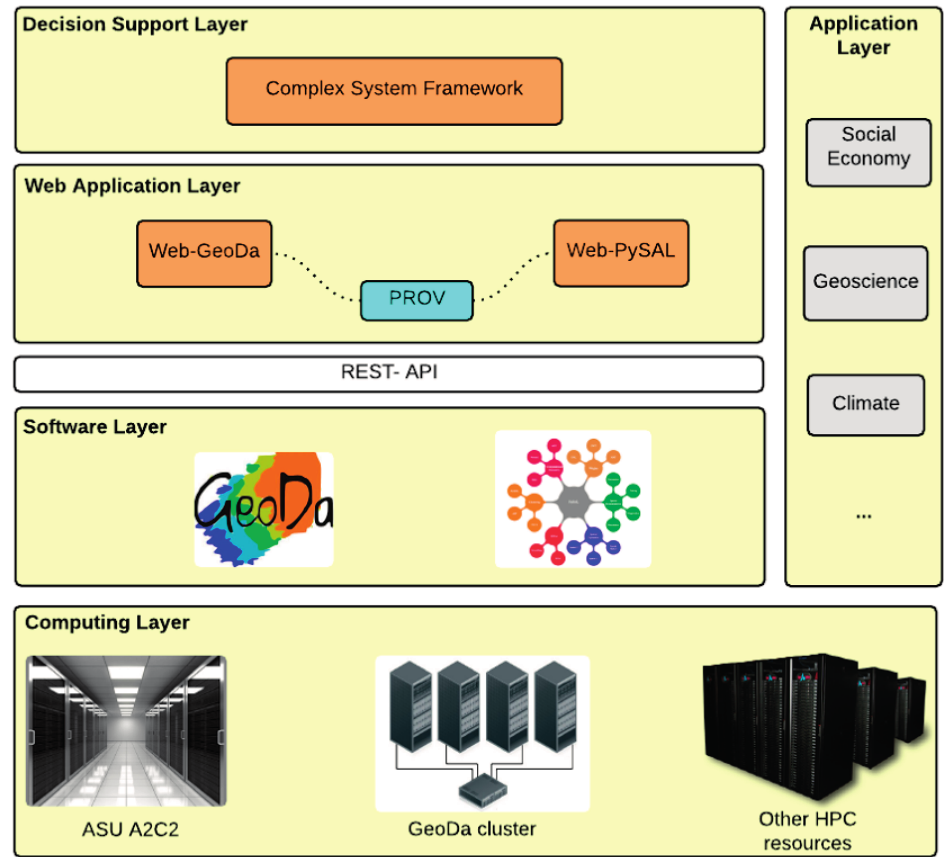
Figure 13. Open geospatial analytics integration